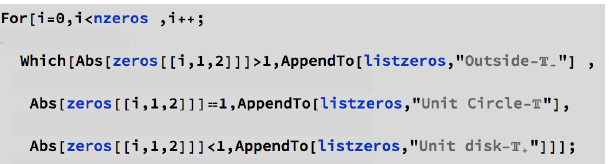
Figure 38. Part of the code structure of the [AZeros] algorithm code responsible for the location, relative to the unit circle, of complex numbers in a given list.